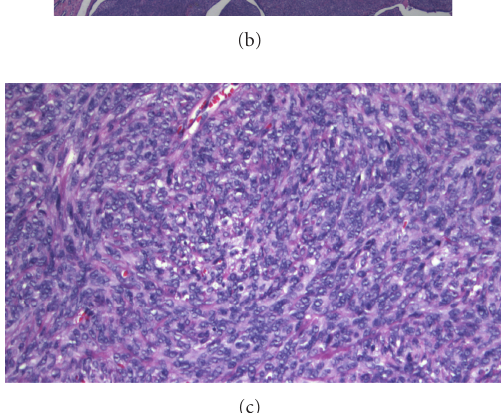
Figure 2: Bisected radical orchiectomy specimen. The tumor can be seen as a smooth, round, pale lesion (arrow) at the mediastinum testis.